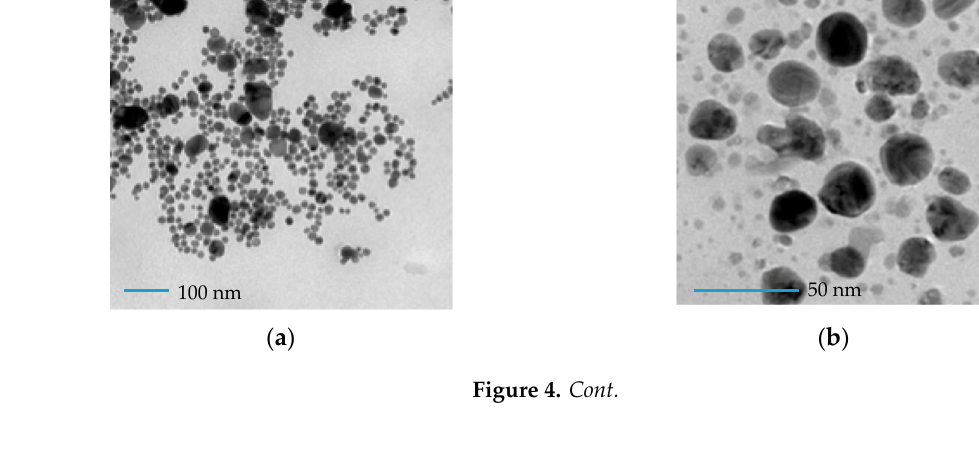
Figure 3. Energy dispersive spectra of a solution of AgNPs deposited on a copper grid.